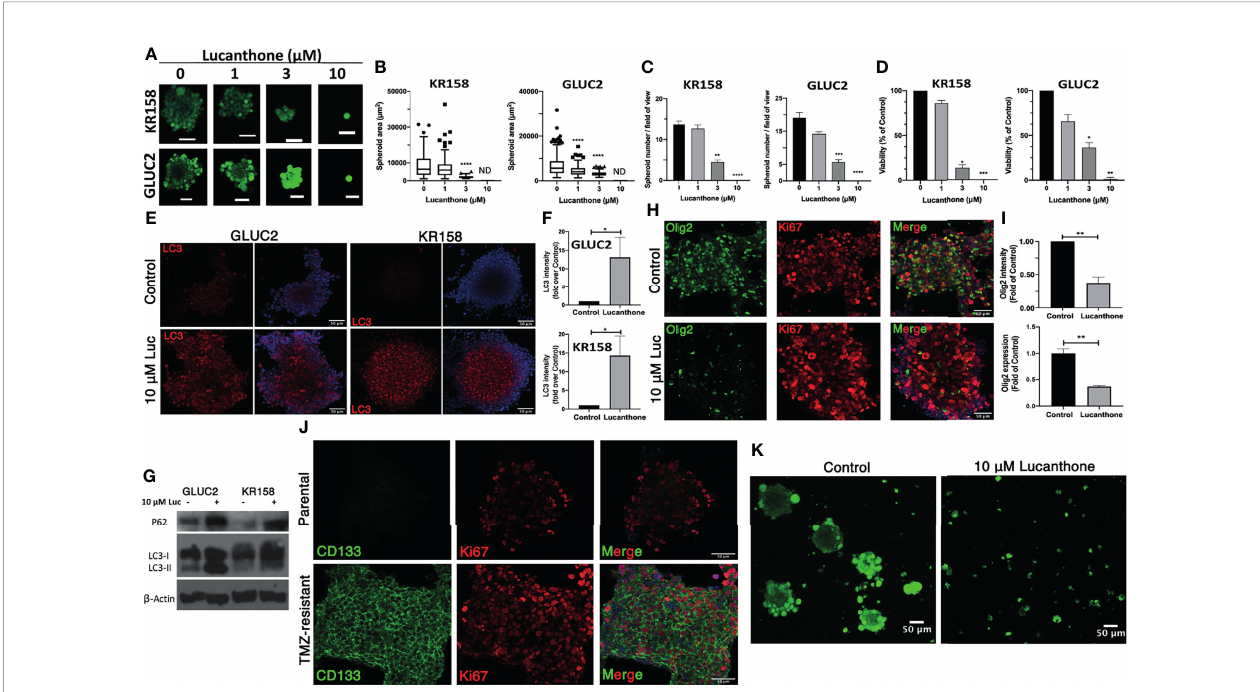
FIGURE 3 | Lucanthone targeted GSC and overcame acquired resistance to temozolomide. GLUC2 and KR158 spheroids were mechanically dissociated, plated overnight and treated with increasing concentrations of lucanthone for 5 days. After treatment, they were stained with Calcein-AM to visualize viable cells. (A) Representative images of KR158 and GLUC2 GSC treated with increasing concentrations of Lucanthone for 5 days; (B) Spheroid area distribution. ****p < 0.0001, Kolmogorov-Smirnov test comparing distributions to control-treated cultures; ND, Not Detected. (C) Spheroid number per fi eld of view; (D) Viability of cultures as determined by MTT assay. Bars are mean +/- SEM, N=3-4 independent experiments. *p < 0.05, **p < 0.01, ***p < 0.001, Dunnett ’ s multiple comparison test to control-treated cells. (E) LC3 staining in GLUC2 and KR158 spheroid cultures treated with media or 10 m M lucanthone for 48 hours; (F) LC3 intensity measured in the same cultures. *p < 0.05, Mann-Whitney test; (G) Olig2 staining in GLUC2 spheroid cultures treated with media (Control) and 10 m M lucanthone-treated for 48 hours; (H) Olig2 intensity and mRNA expression in the same cultures. **p < 0.01, t-test. N=3-4 independent experiments; (I) Immunoblot analysis of p62 and LC3 in protein extracts from GLUC2 and KR158 spheroids with media or 10 m M lucanthone for 48 hours; (J) GLUC2 cells treated with 5 cycles of TMZ stained for the stemness marker CD133 and for the proliferation marker Ki67; (K) TMZ-resistant GLUC2 cells treated with media or 10 m M lucanthone for 5